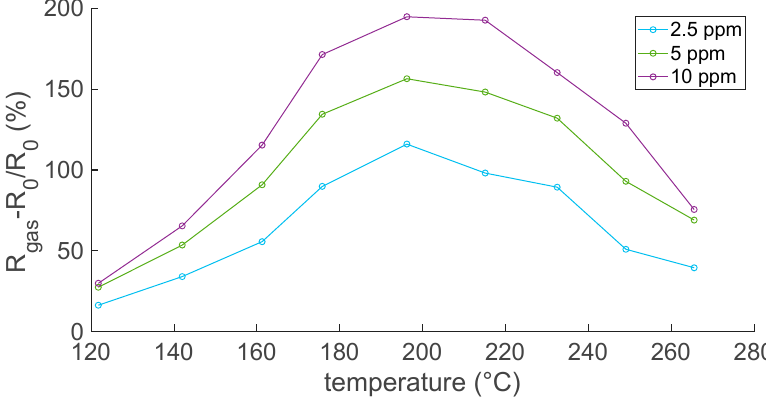
Figure 8. Responses to NO 2 as a function of temperature; air is the carrier gas.